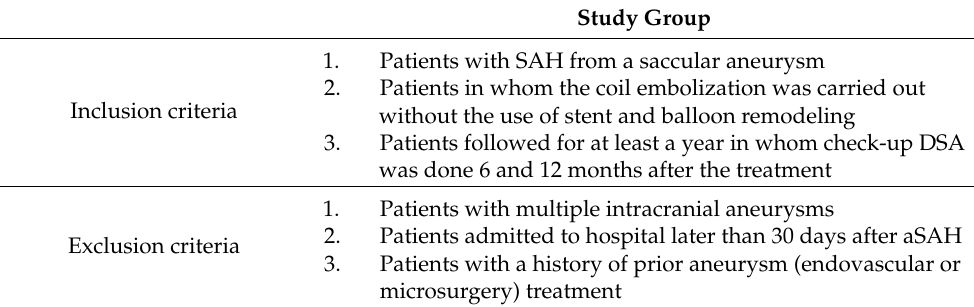
Table 1. Inclusion and exclusion